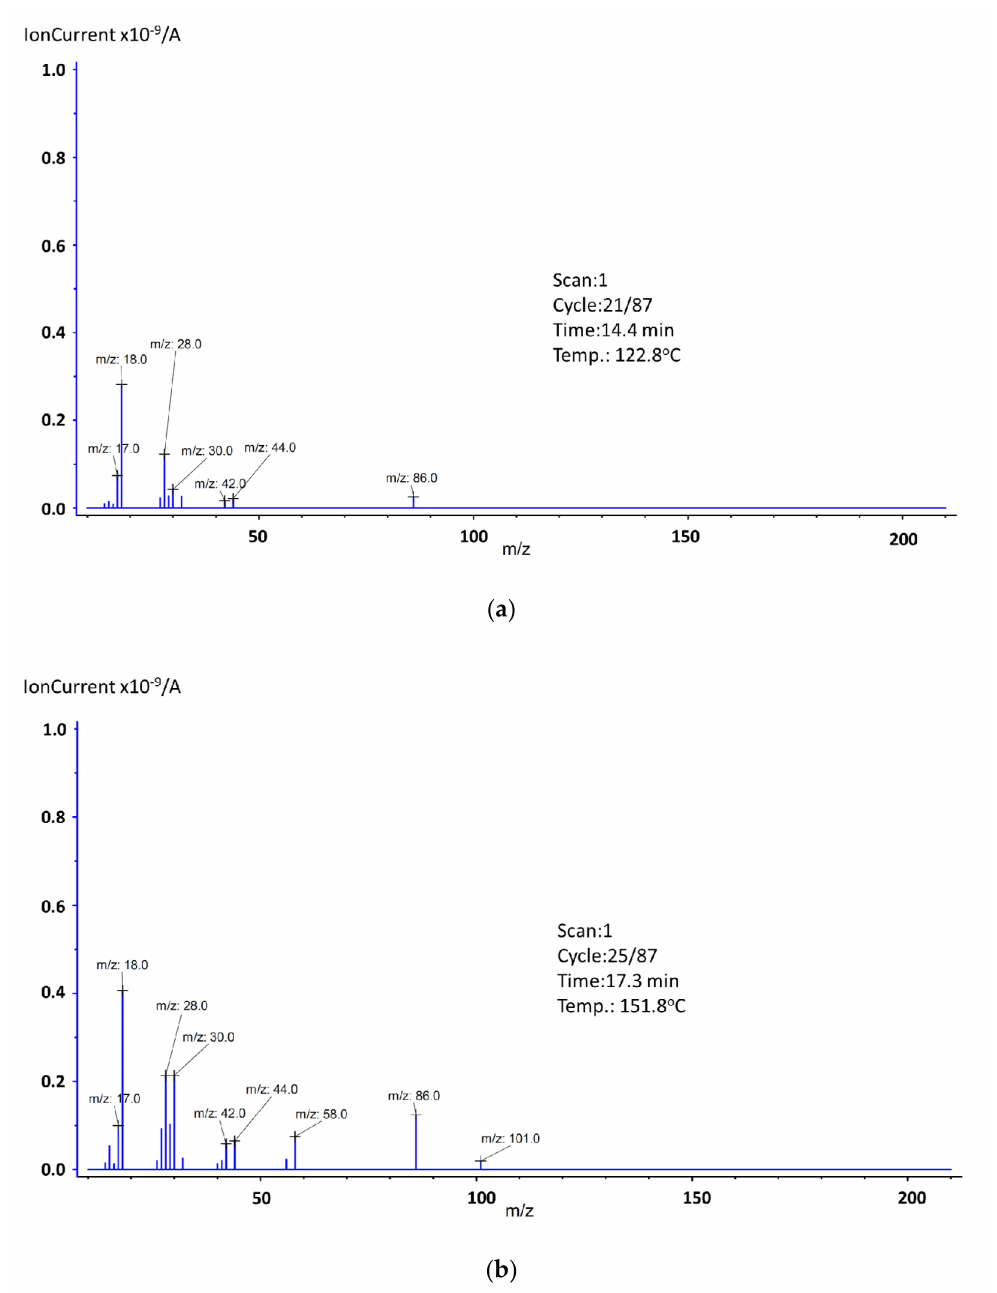
Figure 4. Mass spectra of Tb2,6DClB at endothermic maxima: ( a ) 122.8 ◦ C, ( b ) 151.8 ◦ C. Some shifts compared to the DSC temperature value placed in Table 2 are observed because of the apparatus response